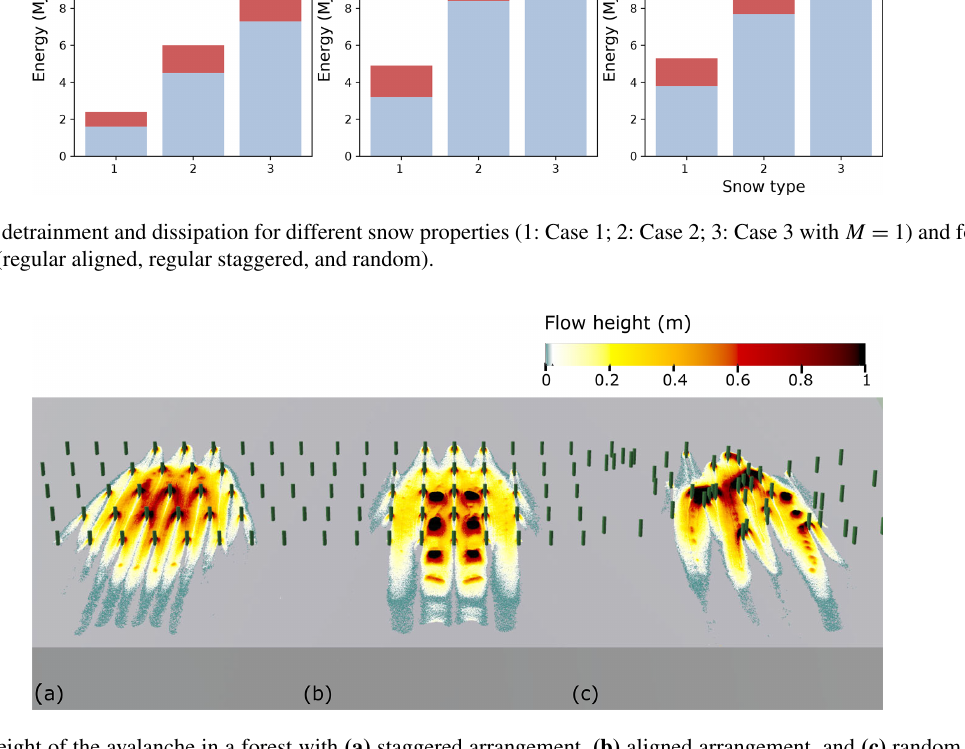
Figure 14. Flow height of the avalanche in a forest with (a) staggered arrangement, (b) aligned arrangement, and (c) random arrangement, (Case 2, v 0 = 6ms − 1